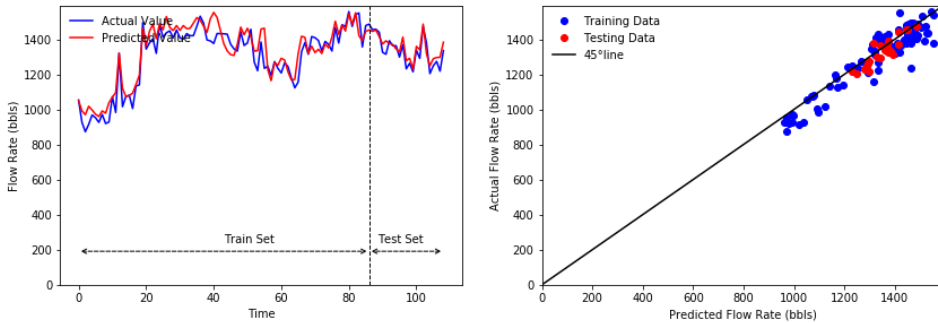
Figure 7. Prediction result of EMD-BP-MLMVN for CS18.